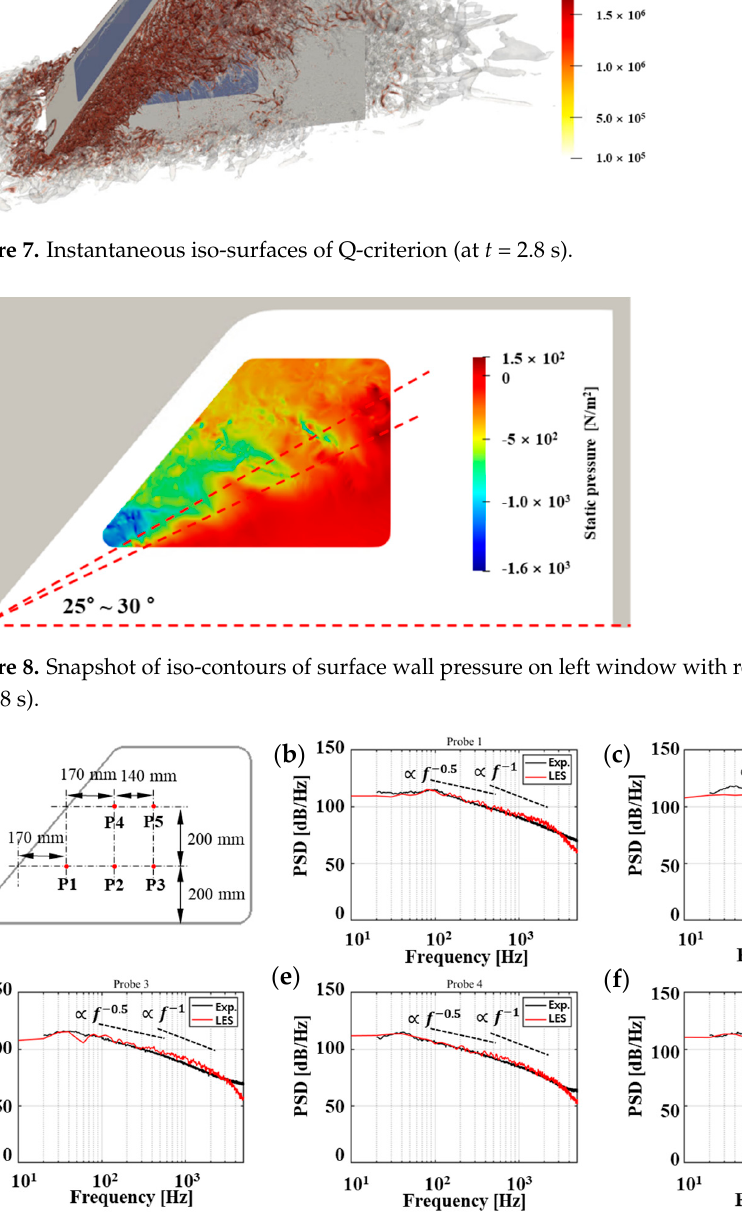
Figure 9. Comparison of power spectral density levels of surface pressure fluctuations monitored at probe locations between numerical and experimental results: ( a ) probe locations; ( b ) probe 1; ( c ) probe 2; ( d ) probe 3; ( e ) probe 4; ( f ) probe 5.